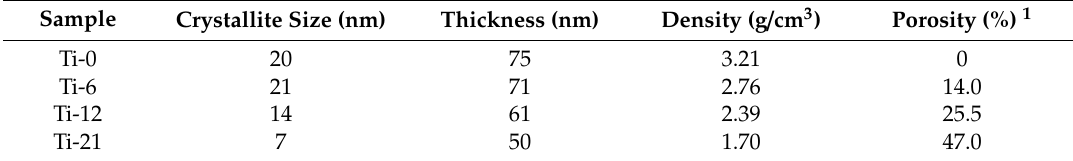
Table 2. Summary of the TiO 2 film characteristics derived from XRD and XRR data.